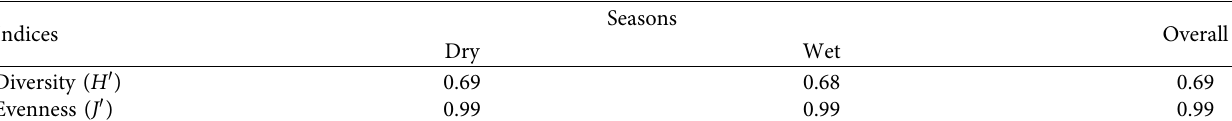
Table 2: Summary of diversity indices ( H ′ and J ′ ) of fish species in Lake Maybahr.